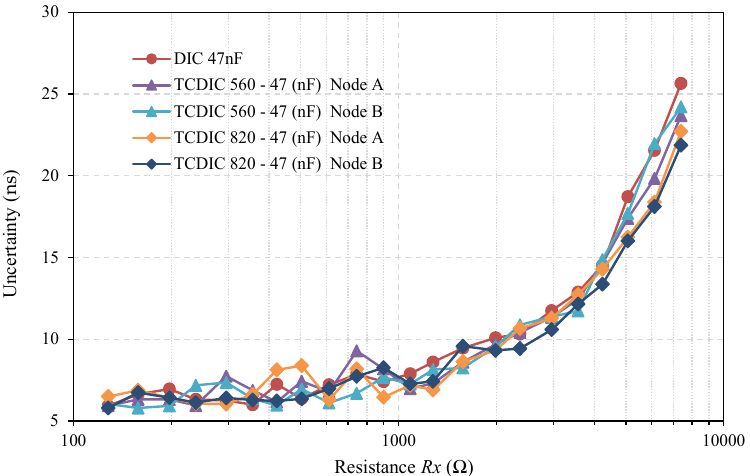
Figure 5. Uncertainty in the measurement of the discharge times in the node corresponding to the DIC’s Pp pin, T , and in nodes A and B of the TCDIC, T A and T B . The X-axis, in log10 scale, shows the resistors used.